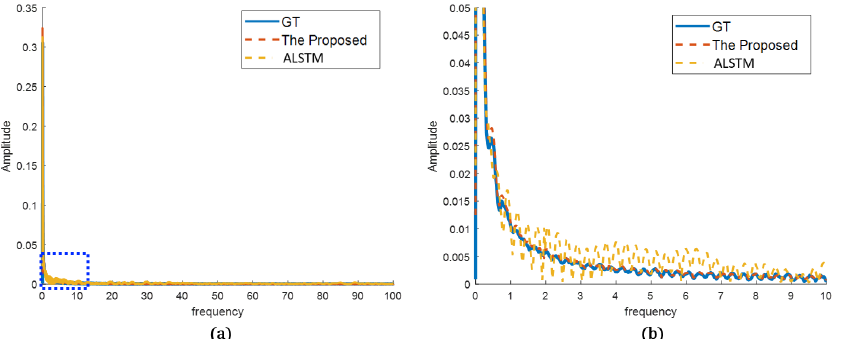
Figure 13. Prediction results in frequency domain (sensor A): ( a ) overview of the proposed and the best of the other methods compared to the GT; ( b ) detailed view of the blue dotted rectangle of ( a ).